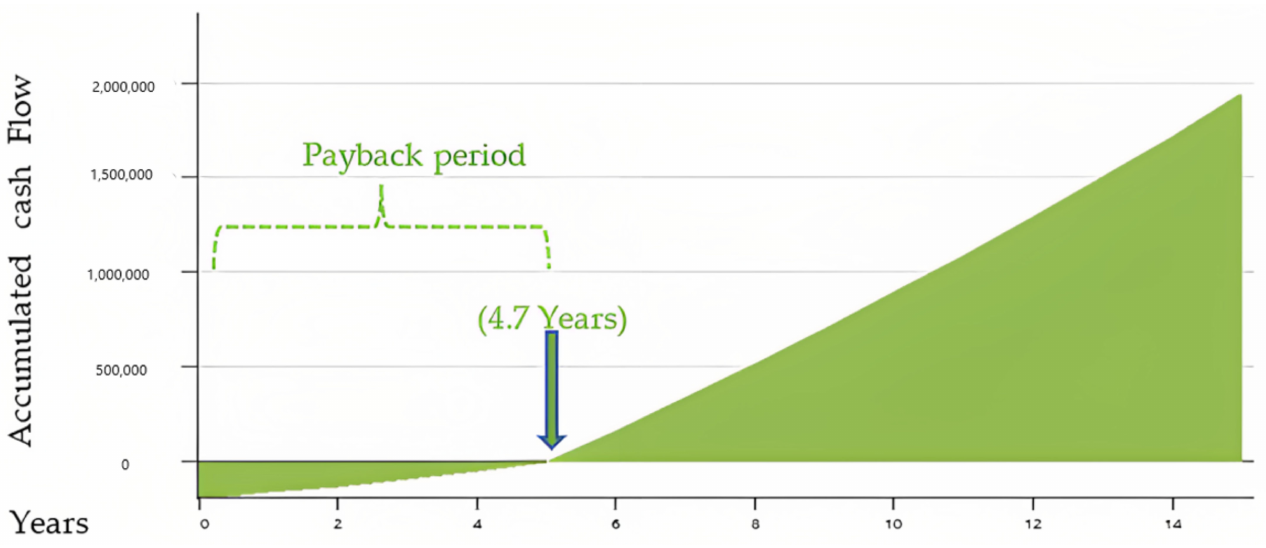
Figure 14. Cumulative cash flow chart of the photovoltaic system, obtained from Retscreen expert